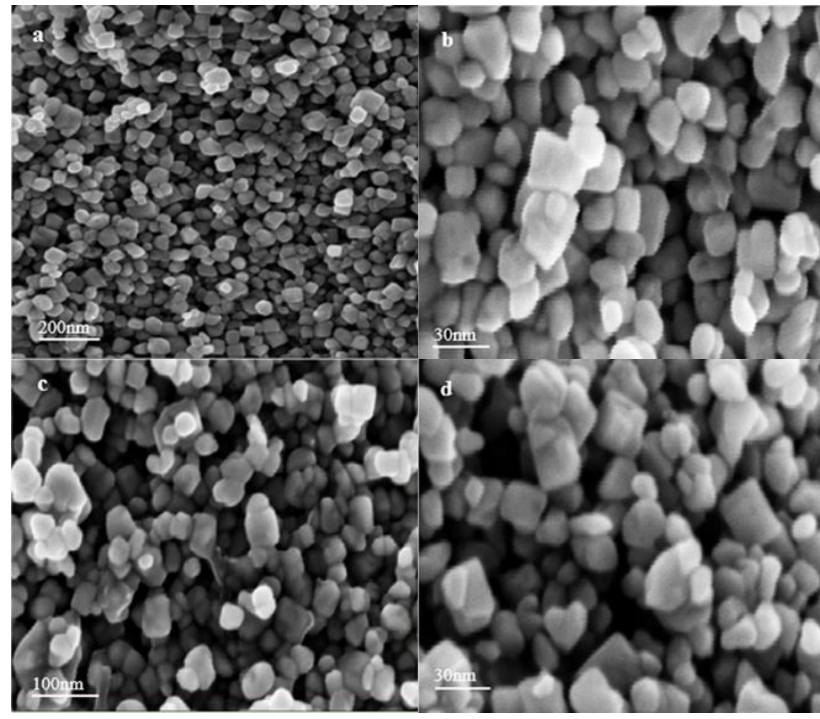
Figure 2. SEM images of TiO 2 -RGO: ( a , b ) TiO 2 -6%RGO, ( c , d ) TiO 2 -12%RGO. Figure 3a,b are the TEM images of TiO 2 -6%RGO. It was observed that the graphene sheets with overlapping wrinkles are interspersed between the TiO 2 particles. The sample which is consistent with the SEM